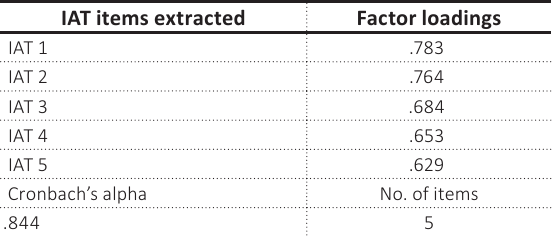
Table 4. Factor: Inflation Accounting